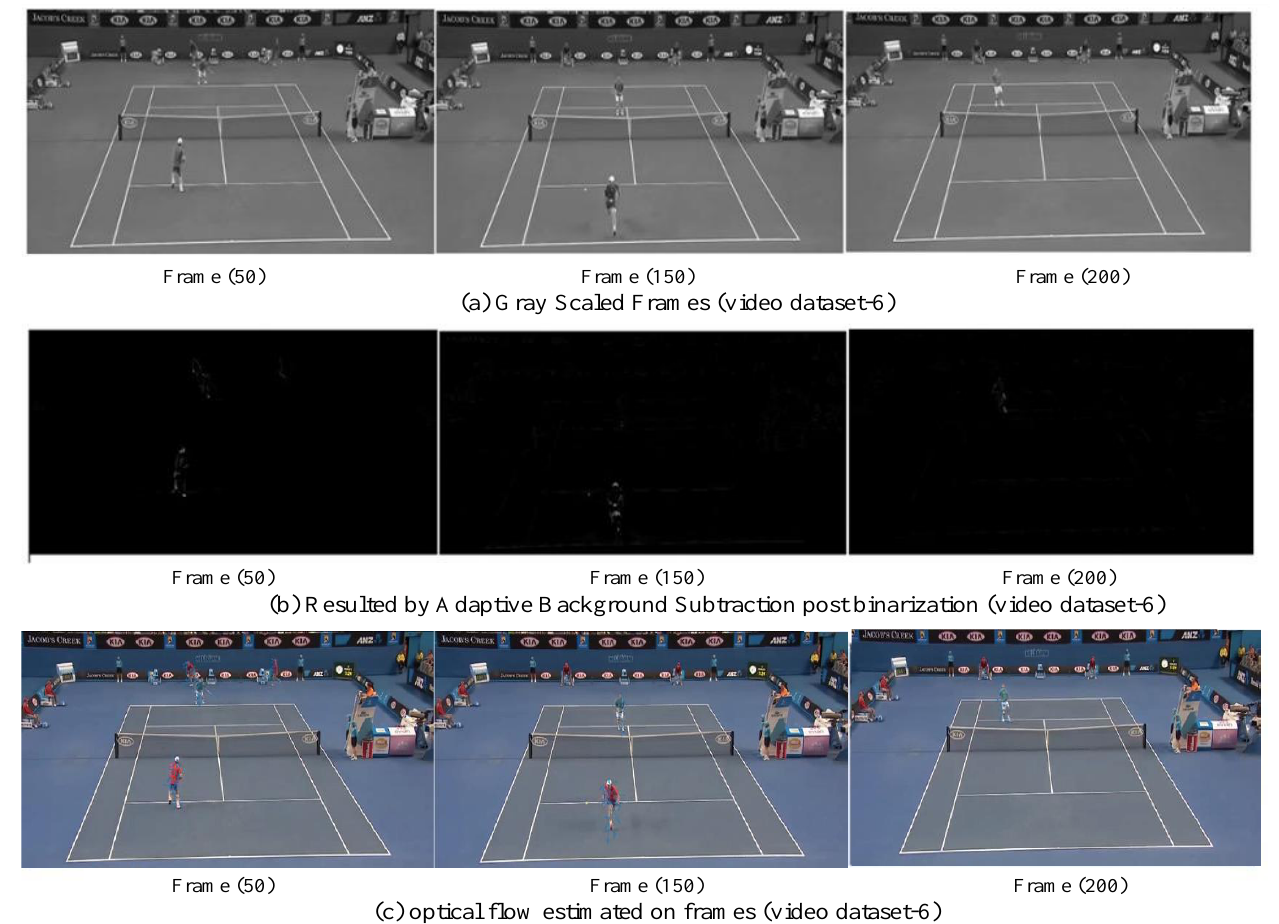
Figure 13. Activity map and pixel sensitivity maps of video dataset 5 by different approaches: ( A ) by Pan et al. in [12]; ( B ) by Mehboob et al. in [13]; ( C ) by Indu, S. in [14]; ( D ) our proposed framework.